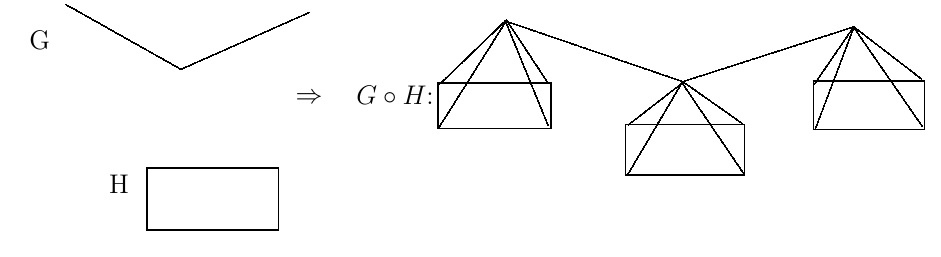
Figure 2. The corona product of G and H